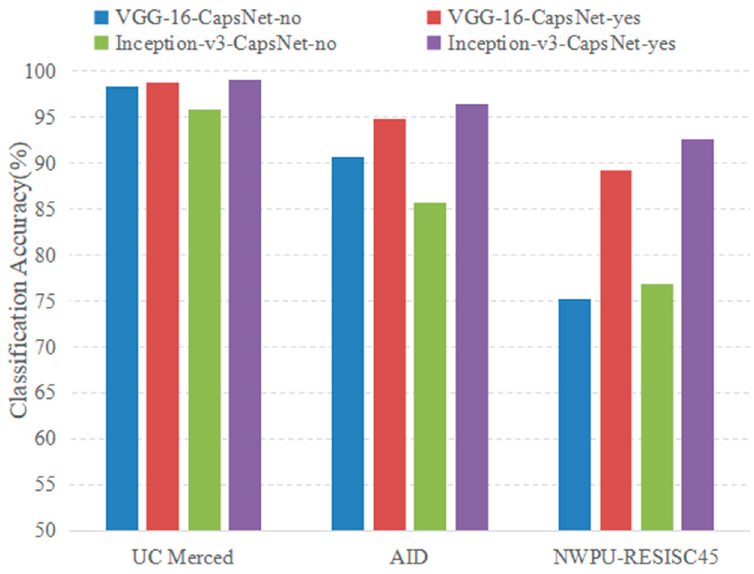
Figure 18. Overall accuracy (%) of the proposed method with and without fine-tuning on three datasets.